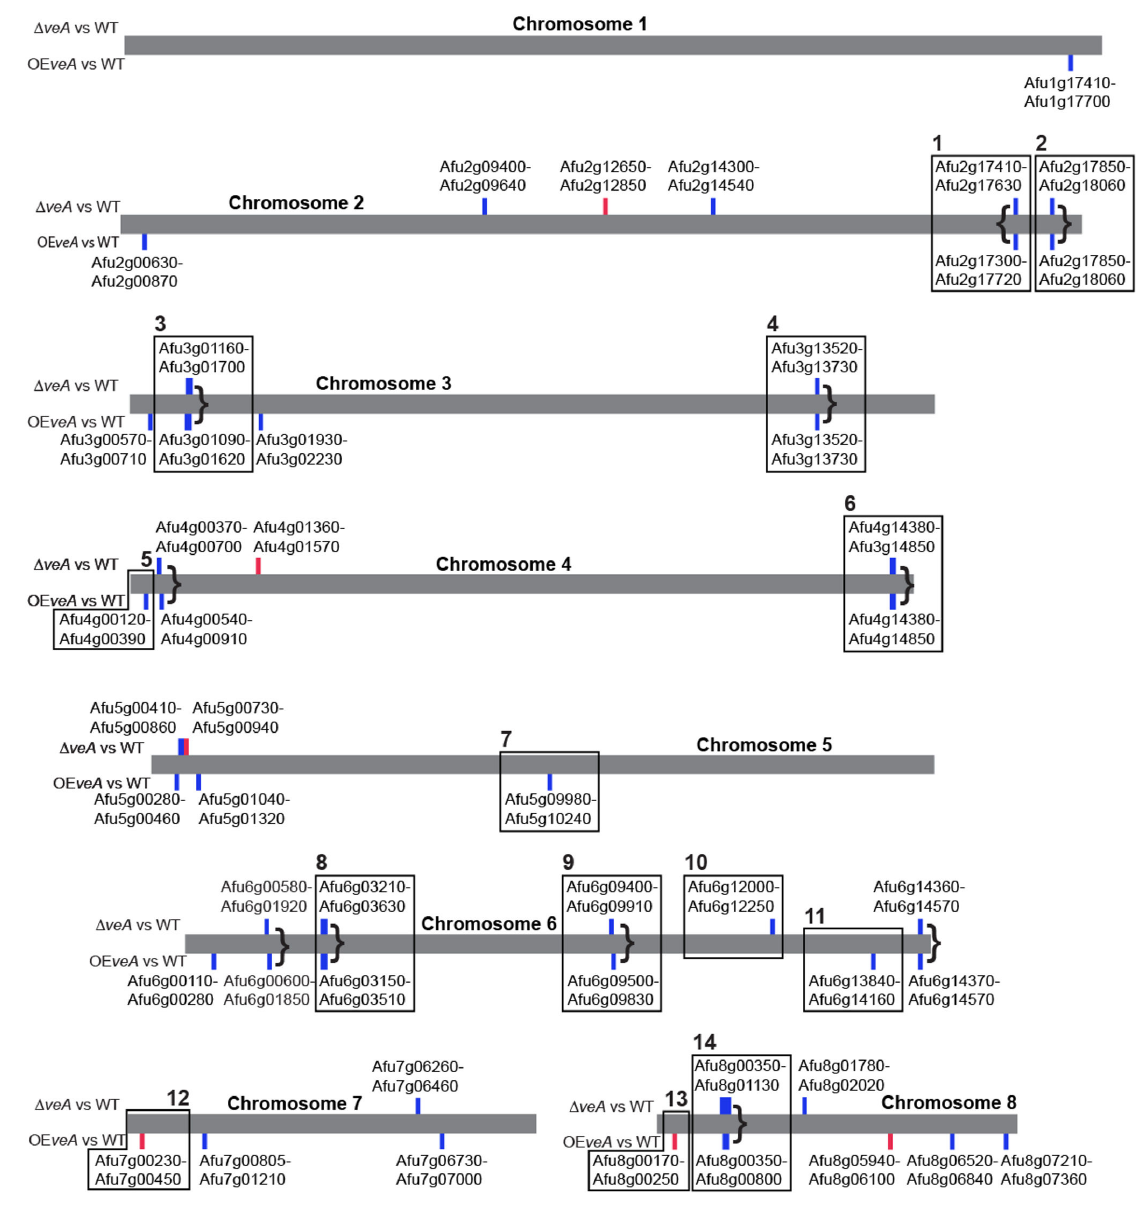
Figure 2. The genome-wide distribution of de novo identified gene clusters that appear to be regulated by veA . De novo identification of gene clusters differentially regulated by the deletion versus wild-type (shown above each chromosome) and overexpression versus wild-type (shown below each chromosome) comparisons. Upregulated gene clusters are represented by red boxes and downregulated gene clusters are represented by blue boxes. Gene clusters identified in both comparisons whose boundaries overlap are denoted by bracket symbols. Previously reported secondary metabolism gene clusters [60,71] are boxed and numbered. 1: This cluster contains a conidial pigment biosynthesis cluster from Afu2g17530 – Afu2g17600 [82]; 2. This cluster contains the Fumigaclavine C cluster from Afu2g17960 – Afu2g18060 [83]; 3. Cluster of unknown function; 4. Cluster of unknown function; 5. This cluster contains an endocrocin secondary metabolism cluster from Afu4g00210 – Afu4g00230 [84]; 6. This cluster contains the pathway responsible for helvolic acid biosynthesis from Afu4g14770 – Afu4g14850 [85]; 7. Cluster of unknown function; 8. Cluster of unknown function; 9. This cluster contains the gliotoxin cluster from Afu6g09630 – Afu6g 09740 [86]; 10. This cluster contains the fumiquinazoline biosynthetic cluster from Afu6g12040 – Afu6g12110 [87]; 11. Cluster of unknown function; 12. Cluster of unknown function; 13. This cluster contains the fumitremorgin G cluster from Afu8g00260 – Afu8g00170 [76]; 14. This cluster contains the fumagillin gene cluster from Afu8g00370 – Afu8g00520 [53]; and the pseurotin A cluster from Afu8g00530 – Afu8g00570 [88]. doi: 10.1371/journal.pone.0077147.g002 PLOS ONE |